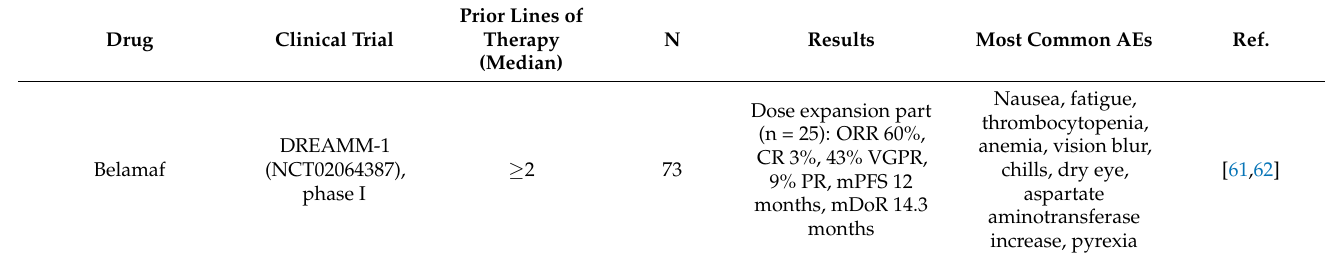
Table 1. Summary of current clinical trials of anti-BCMA ADC.